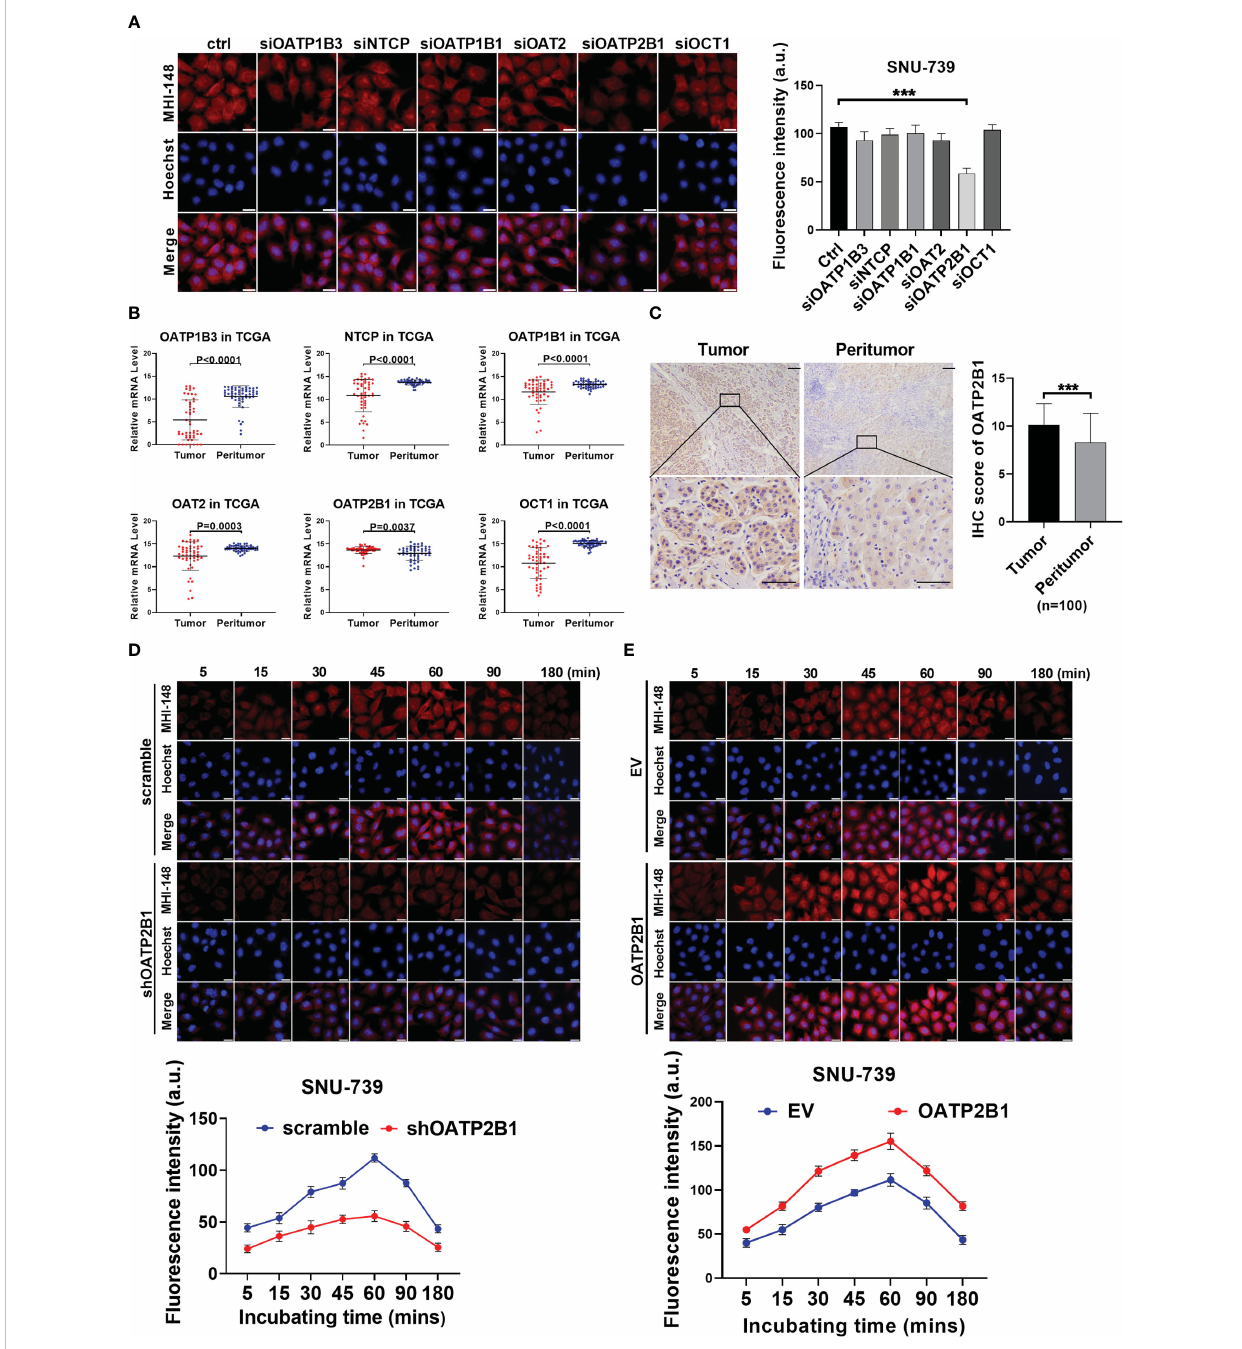
FIGURE 2 OATP2B1 is involved in uptake of MHI-148 into HCC cells in vitro . (A) Near-infrared fl uorescence imaging of SNU-739 cells transfected with siRNAs against different SLC transporters and stained with MHI-148 for 60 minutes. (B) The relative mRNA expression levels of tumor and peritumor of SLC transporters were analyzed by transcriptome sequencing data from The Cancer Genome Atlas (TCGA). (C) Representative immunohistochemical (IHC) staining image (Left) and IHC score (Right) of OATP2B1 in 100 paired HCC tissues (tumor and peritumor). Data are expressed as mean ± SD. Scale bar, 50µm. (D, E) Determination of MHI-148 uptake in SNU-739 cells with knockdown or overexpression of OATP2B1. Data shown are the mean ± SD from three independent experiments, where appropriate. ***P <